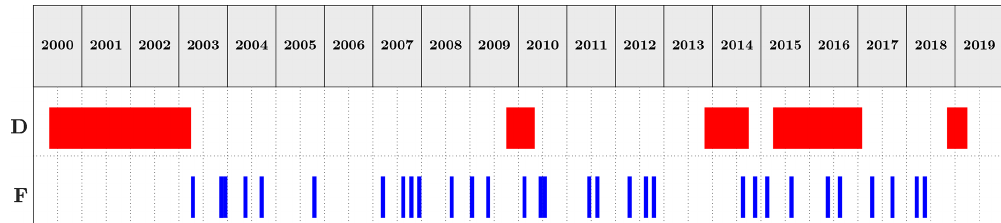
Figure 7. Overview of floods and droughts hitting the Dominican Republic over the period 2000–2019.